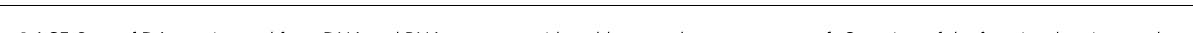
Fig. 4 ACE-Scan of DAs engineered from DNA and RNA aptamers with stable secondary structures. a , b Overview of the functional regions and secondary structure of the ( a ) ATP RNA aptamer, and ( b ) cocaine DNA aptamer. The ligand and bases directly involved in ligand recognition are colored in green. Both the ATP RNA and cocaine DNA consensus aptamer sequences were appended with 3 nucleotides at the 5 ʹ and 3 ʹ ends (gray bases), which are expected to be single stranded and serve as extension toeholds for ACE hybridization. c – h 5 ʹ heat maps showing the ( c , d ) experimental hybridization af fi nity landscapes, ( e , f ) buffer-only k off landscapes, and ( g , h ) k * off landscapes under high ligand concentrations (10 mM ATP and 100 µ M cocaine) for 7- to 20-mer ATP RNA and 8- to 15-mer cocaine DNA DAs, respectively. Whereas a rich induced fi t ligand-binding landscape is observed for ATP RNA DAs, cocaine DNA DAs do not exhibit induced fi